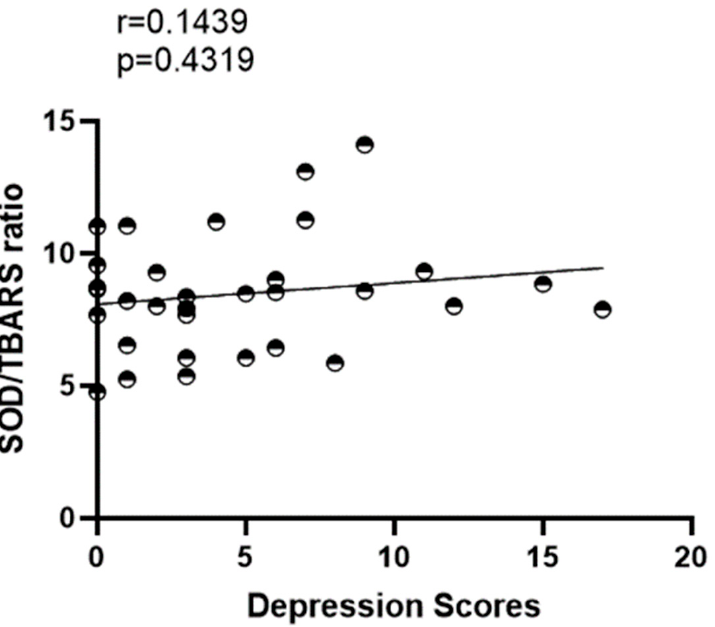
Figure 3. A correlation analysis was conducted among the ratio of SOD/TBARS and the intensity of depression symptoms in master athletes.